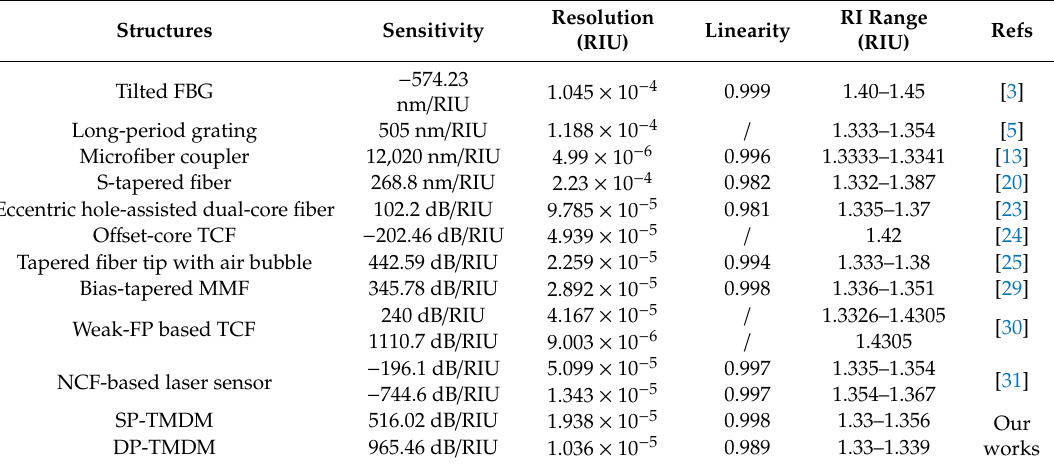
Table 1. Comparisons of various fiber RI